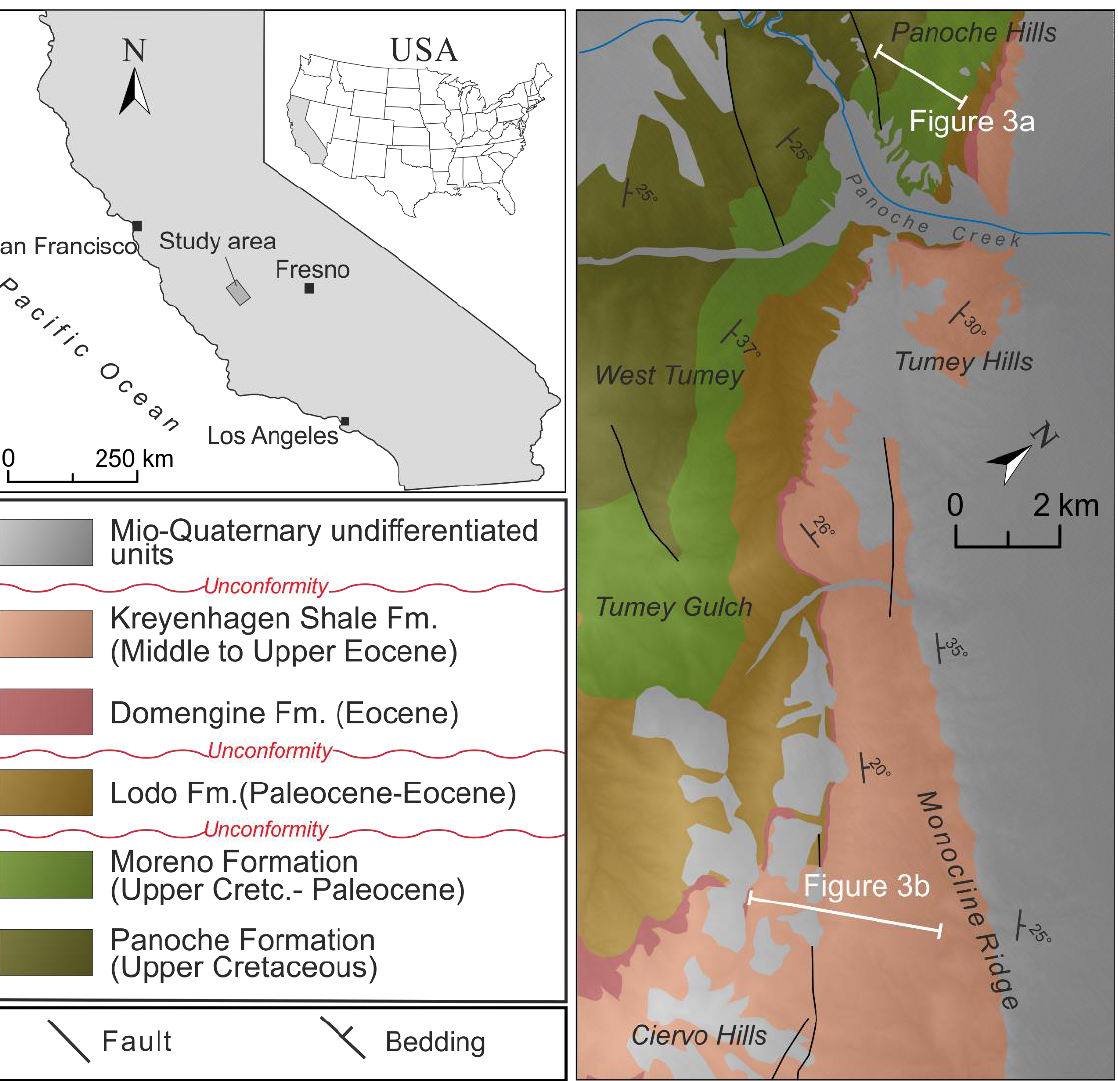
Figure 1. The location of the giant sand injection complexes in central California and a geological map. The Panoche Giant Injection Complex (PGIC) [1] occurs within Upper Cretaceous and Danian strata Panoche and Moreno formations. The white bar in the Panoche Hills is the approximate line of the section sampled and represented in Figure 3a. The Tumey Giant Injection Complex (TGIC) occurs within the Eocene Kreyenhagen Formation. The white bar along Monocline Ridge is the approximate line of the section sampled and represented in Figure 3b.